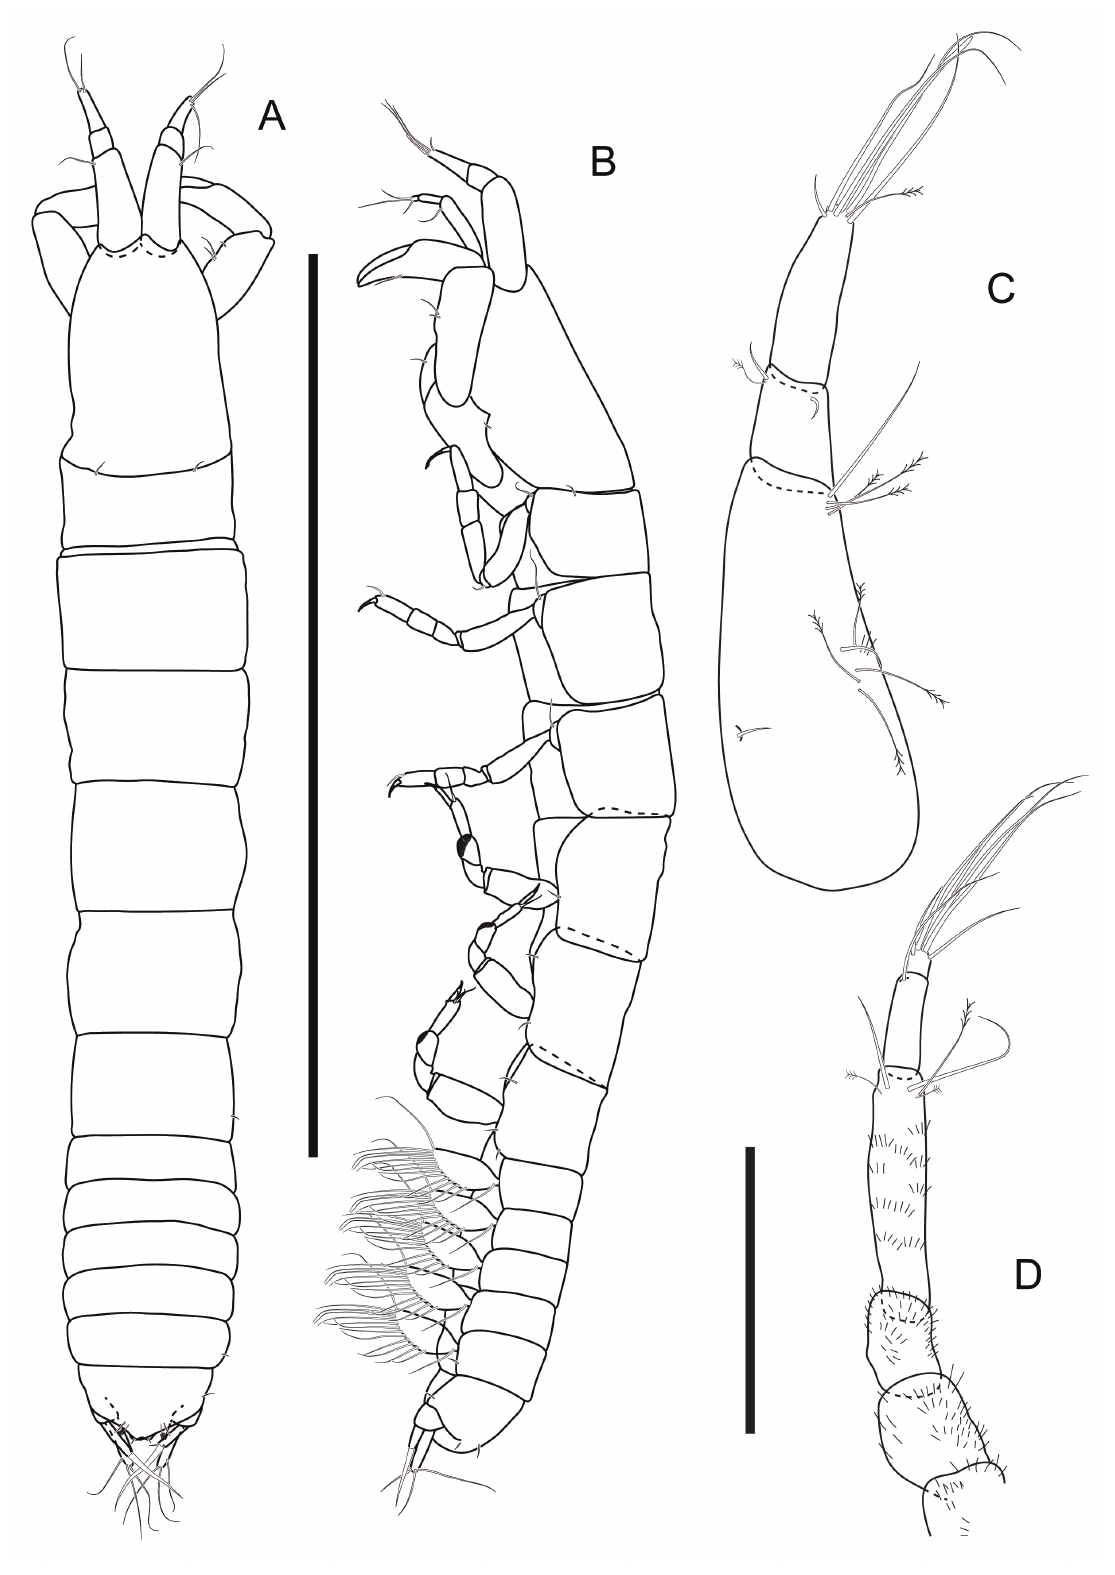
Fig. 2. Typhlotanais andradeorum sp. nov. A . ♀ (MNRJ 18207), dorsal view. B–D . Paratype (MZUSP 32839), ♀, dissected. B . Lateral view. C . Antennule. D . Antenna. Scale bars: A–B = 1 mm; C–D = 0.1